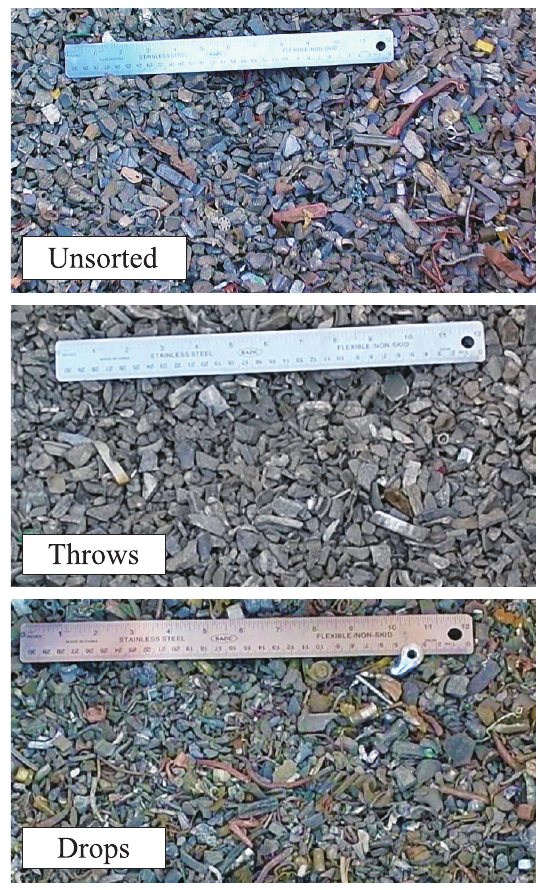
Fig. 6 (Top) Scrap metal feedstock consisting of fine Zorba donated by a local recycling firm. (Middle) Light alu - minum fraction thrown by the EDX sorter. (Bottom) Heavy fraction in the drop bin.